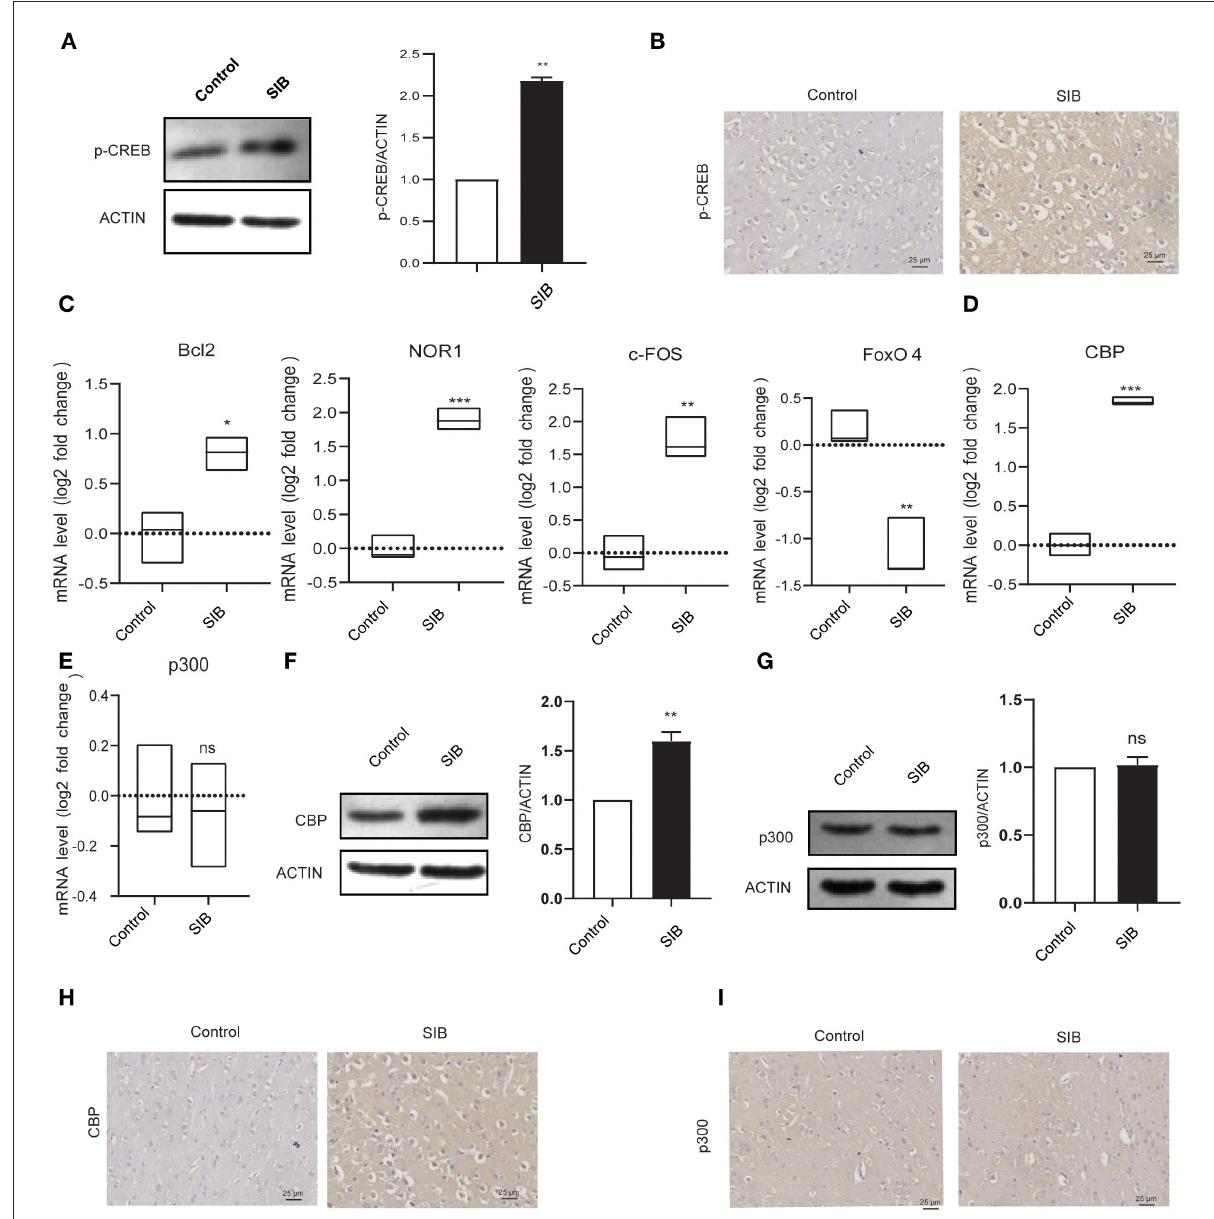
FIGURE3 CBP and p-CREB are significantly increased in Mink brain. (A) The protein levels of p-CREB in brain tissues, assayed by western blot. (B) Representative IHC stains of p-CREB in the brain tissues. Scale bars, 25 µ m. Three micrographs per individual were performed for the photomicrographs. (C) The mRNA levels of Bcl2 , NOR1 , FoxO4 , and c-FOS in brain tissues, assayed by qRT-PCR. (D) The mRNA levels of CBP in brain tissues, assayed by qRT-PCR. (E) The mRNA levels of p300 in brain tissues, assayed by qRT-PCR. (F) The protein levels of CBP in brain tissues, assayed by western blot. (G) The protein levels of p300 in brain tissues, assayed by western blot. (H) Representative IHC stains of CBP in the brain tissues. Scale bars, 25 µ m. Three micrographs per individual were performed for the photomicrographs. (I) Representative IHC stains of p300 in the brain tissues. Scale bars, 25 µ m. Three micrographs per individual were performed for the photomicrographs. Data shown represent the mean ± SEM; Control, n = 10; SIB, n = 8. * p < 0.05, ** p < 0.01, *** p < 0.001, n.s., no significance.